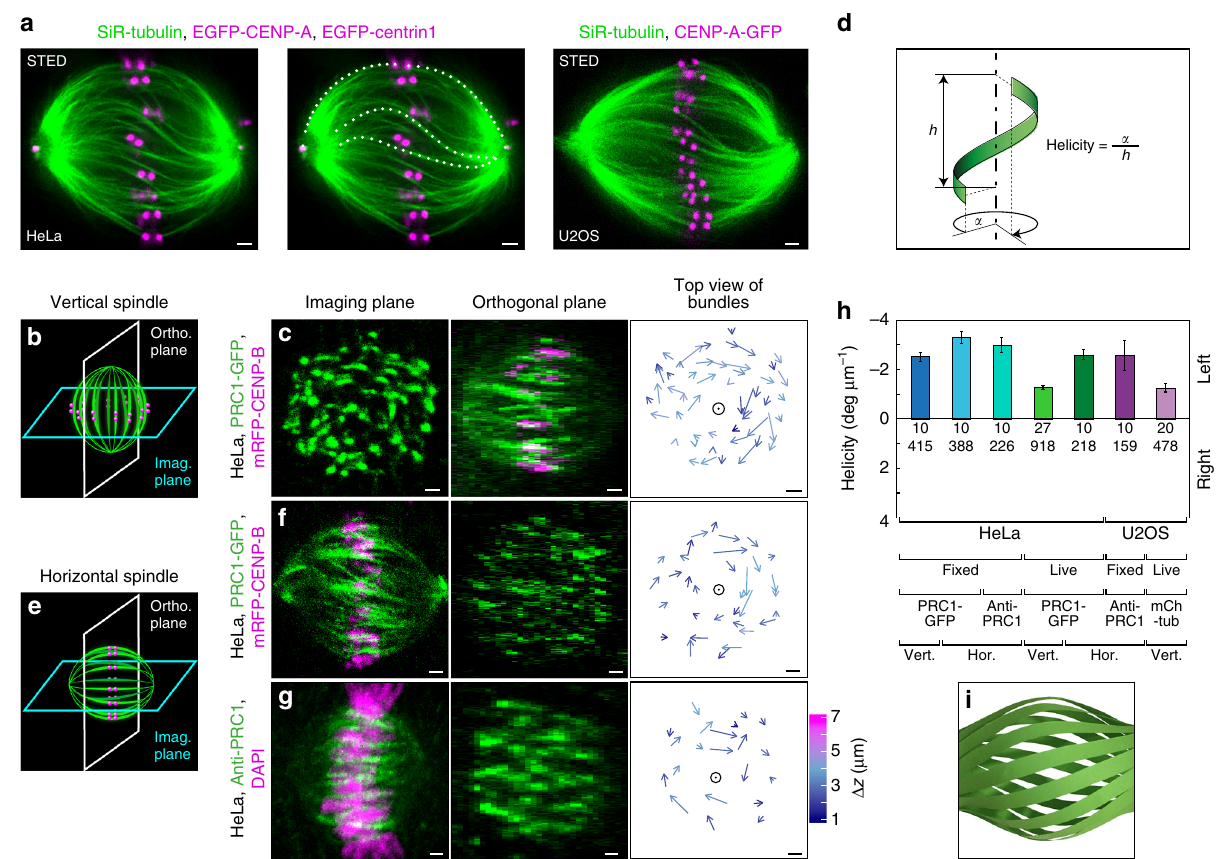
Fig. 1 Mitotic spindle is chiral. a STED image (single z -plane) of metaphase spindle in a live HeLa cell expressing EGFP-CENP-A and EGFP-centrin1 (both shown in magenta) (left and middle; middle panel shows traces of microtubule bundles superimposed on the image), and in a live U2OS cell expressing CENP-A-GFP (magenta) (right). Microtubules are labeled with SiR-tubulin (green). b Imaging scheme of a vertically oriented spindle. c Imaging plane of a vertical spindle in a fi xed HeLa cell expressing PRC1-GFP and mRFP-CENP-B (only PRC1-GFP is shown) (left); orthogonal plane of the same spindle (middle); arrows connecting starting and ending points of PRC1-GFP bundles traced upwards (right). Longer arrows roughly correspond to larger twist around the spindle axis (circle), colors show z -distance between starting and ending points, see color bar in g . d Schematic representation of the microtubule bundle helicity measurement. e Imaging scheme of a horizontally oriented spindle. f Horizontal spindle in a fi xed HeLa cell expressing PRC1- GFP and mRFP-CENP-B, legend as in c . g Horizontal spindle in a fi xed unlabeled HeLa cell immunostained for PRC1, with DNA stained by DAPI, legend as in c . Images in c left, and f , g middle are single planes; images in c middle, and f , g left are maximum intensity projections of fi ve central planes. h Spindle helicity averaged over bundles for different conditions (vertical and horizontal spindles, fi xed and live cells) and cell lines as indicated. Cell lines used were: HeLa cells expressing PRC1-GFP (1st, 2nd, 4th, and 5th bars), unlabeled HeLa cells immunostained for PRC1 (3rd bar), unlabeled U2OS cells immunostained for PRC1 (6th bar), U2OS cells expressing CENP-A-GFP, mCherry- α -tubulin, and photoactivatable (PA)-GFP-tubulin (7th bar). Data are representative of 4 independent experiments for unlabeled HeLa and U2OS cells immunostained for PRC1 and 3 independent experiments for all other conditions. Numbers represent the number of cells (top) and bundles (bottom). Data for individual cells are shown in Supplementary Fig. 1e. i Paper model of the spindle showing left-handed helicity of microtubule bundles and chirality of the whole spindle. Scale bars, 1 μ m; error bars,